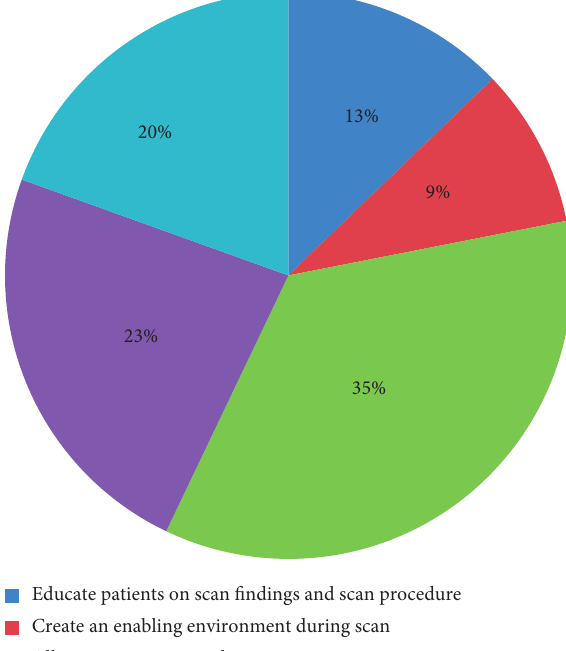
Figure 1: Participants’ suggestions to doctors to make their ex- perience better during their next ultrasound